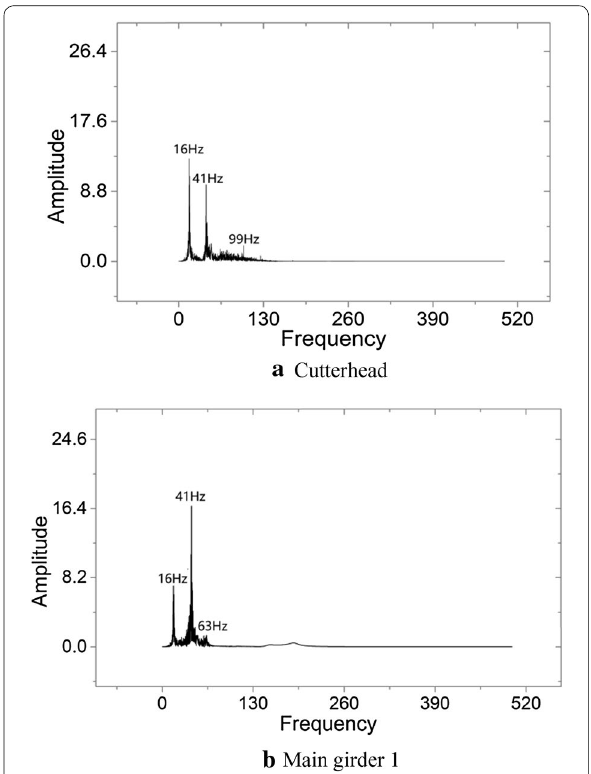
Figure 9 Vibration responses in the overturning